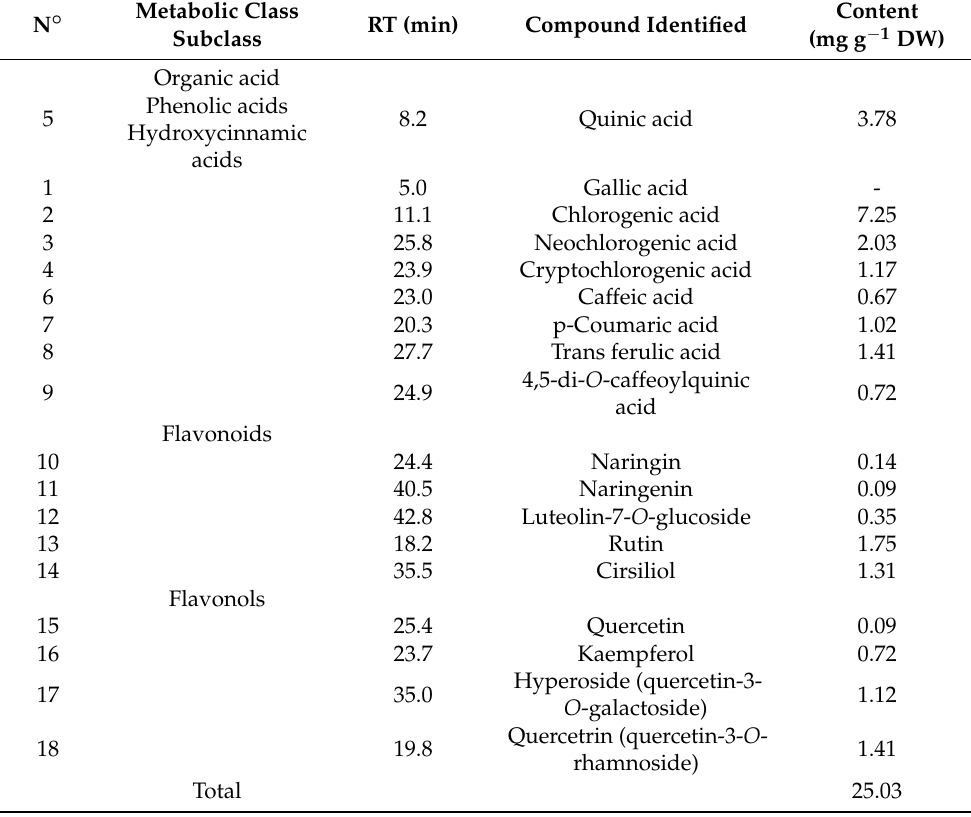
Table 2. Content of phenolic acids, flavonoids and flavonols (mg g − 1 DW) identified in the hydro- ethanolic extract of C. maritimum leaves by